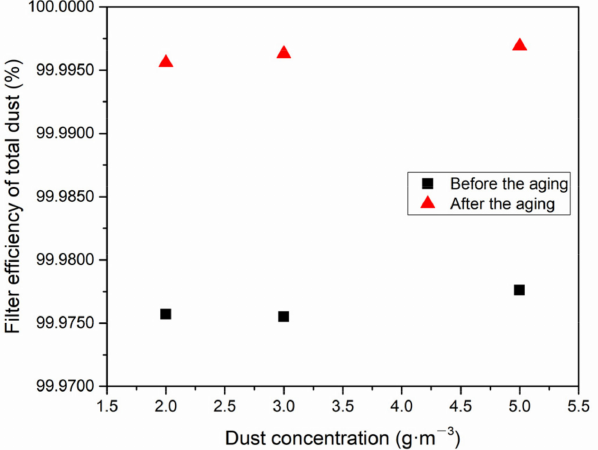
Figure 7. Filtration efficiency of filter media for total dust at different inlet dust concentrations.